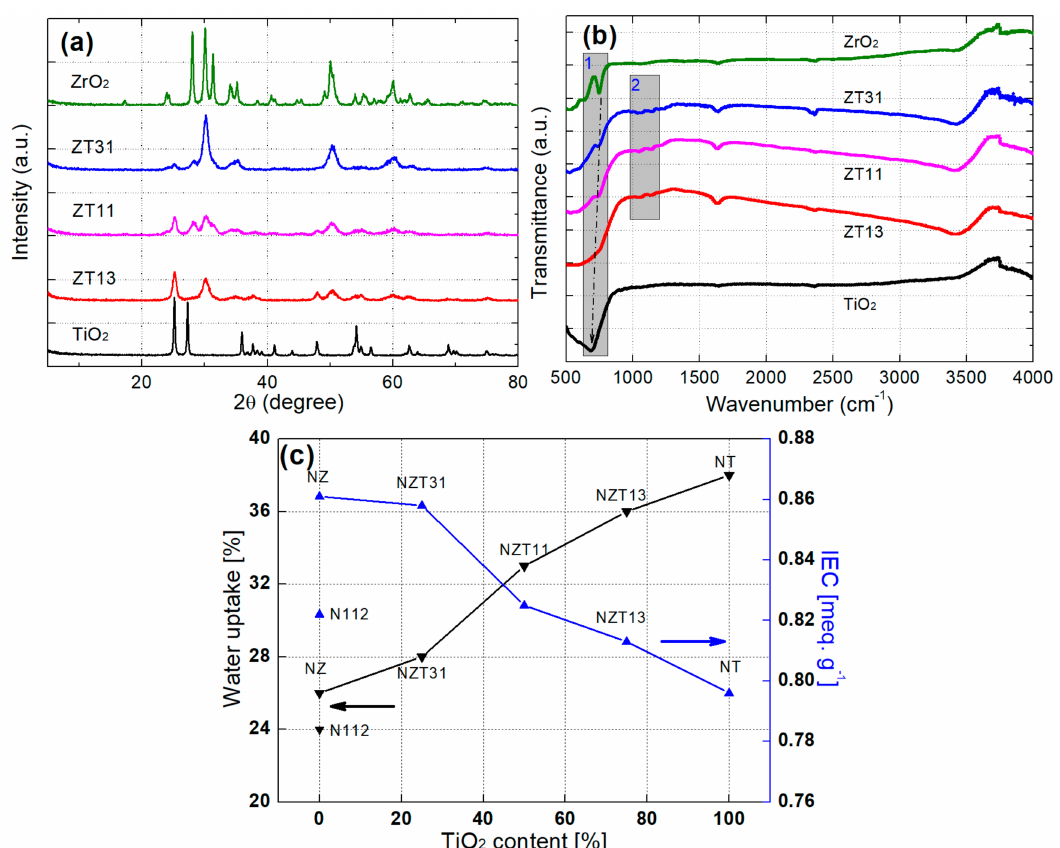
Figure 3. ( a ) X-ray diffraction patterns; ( b ) FT-IR spectra of ZrO 2 , ZrO 2 -TiO 2 with different Zr:Ti ratios (Zr:Ti = 3:1, 1:1, and 1:3) and TiO 2 particles; ( c ) Water uptake and ion exchange capacity (IEC) of N112 and the composite membranes (NZ, NT, NZT31, NZT11,